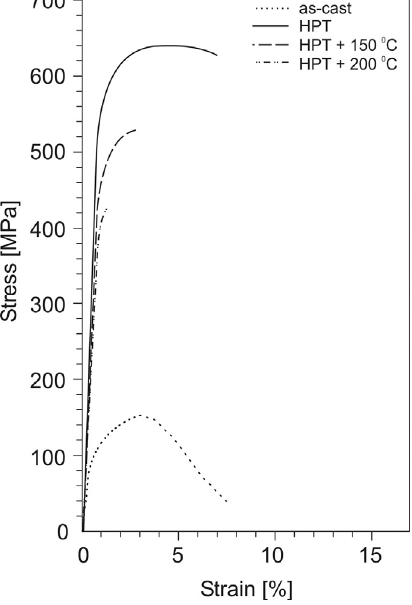
Figure 8. Stress–strain curves for tensile test specimens of the Al–9% Ce alloy in as-cast state, after HPT, and subsequent annealing